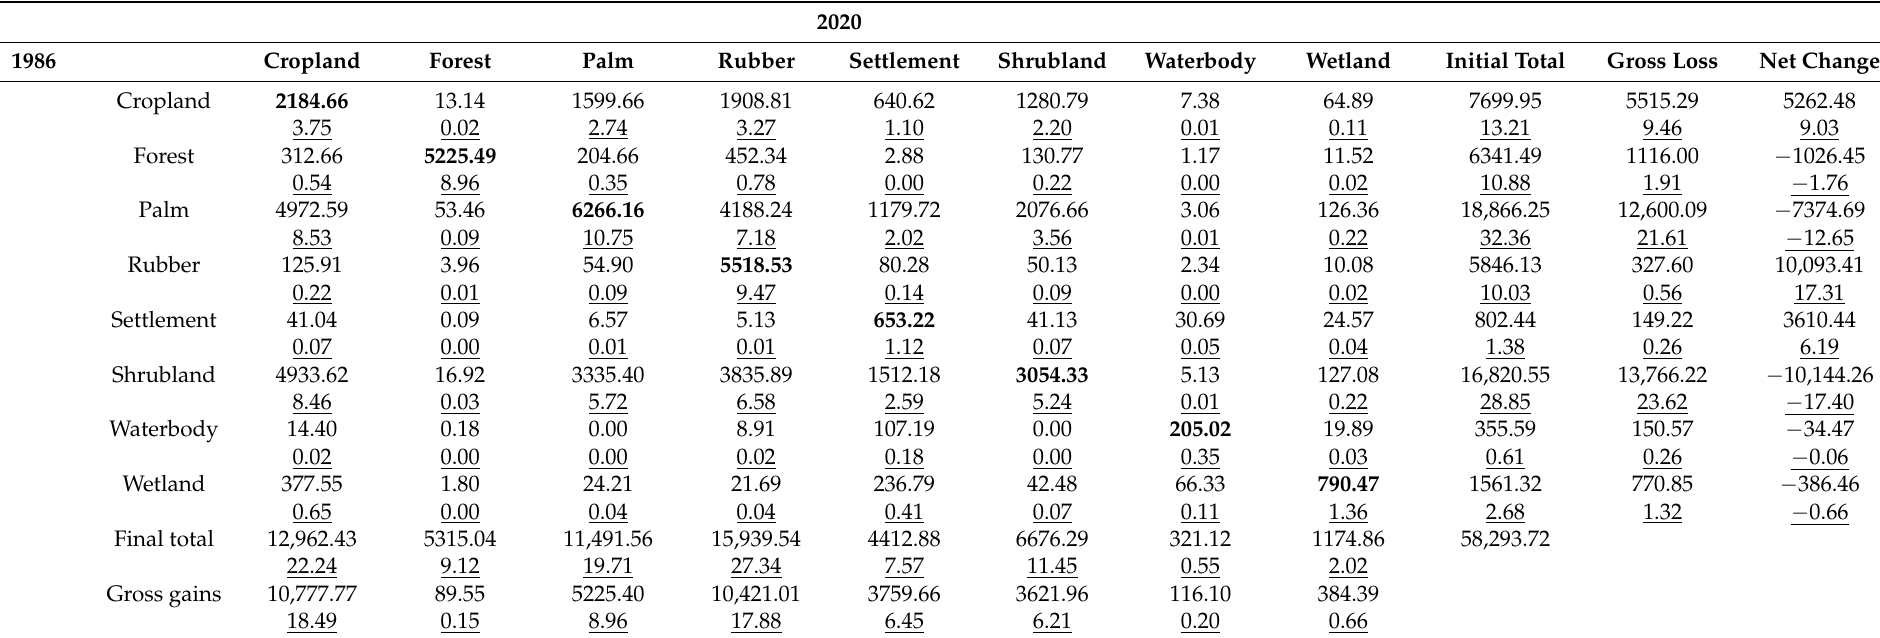
Table 5. Cross tabulation matrices for 1986–2020: area in ha (top values), percentage of total land area (bottom value underlined), The diagonal (in bold) values indicates the persistence of land cover